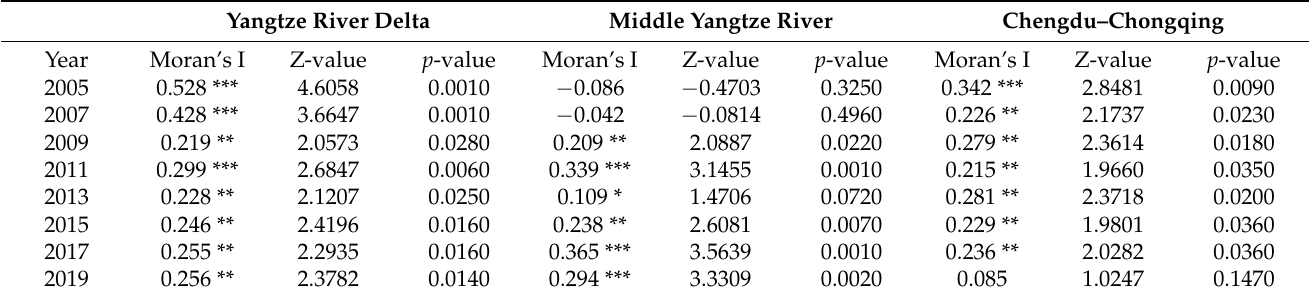
Table 4. Global spatial autocorrelation results of WEFs of three urban agglomerations from 2005–2019. Yangtze River